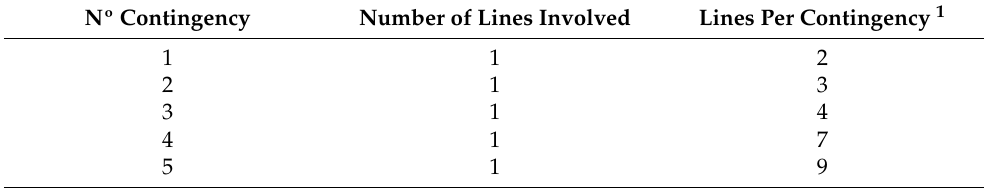
Table 2. Contingencies considered and number of lines involved in each contingency. Nº Contingency Number of Lines Involved Lines Per Contingency 1